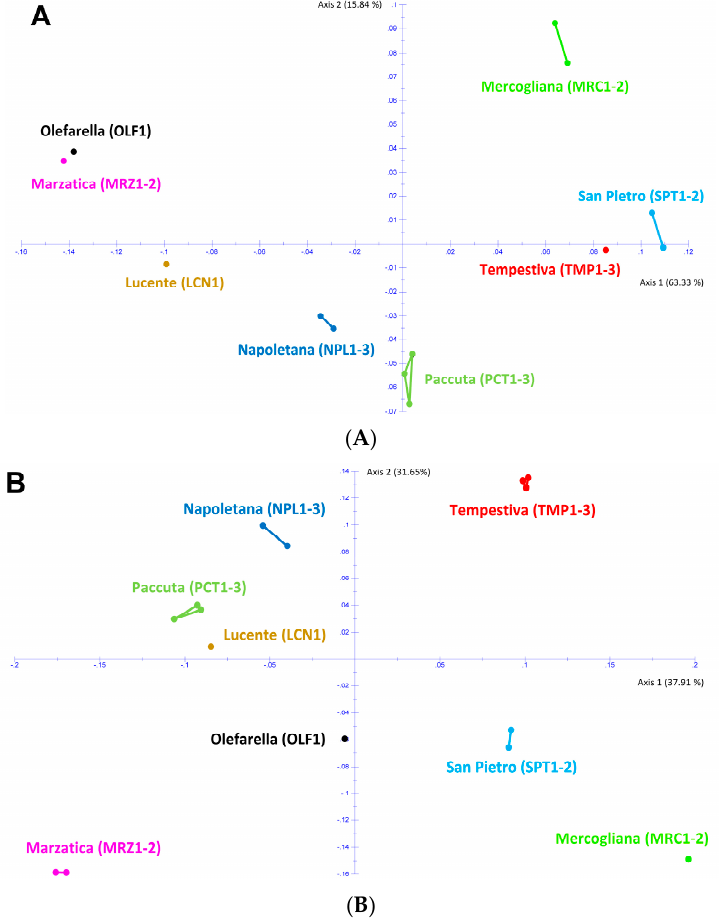
Figure 2. PCoA of the 17 chestnut samples from eight C. sativa cultivars of the Regional Park “Volcanic Area of Roccamonfina and Foce Garigliano” based on their DNA polymorphisms obtained by RAPD ( A ) and KASP ( B ) molecular